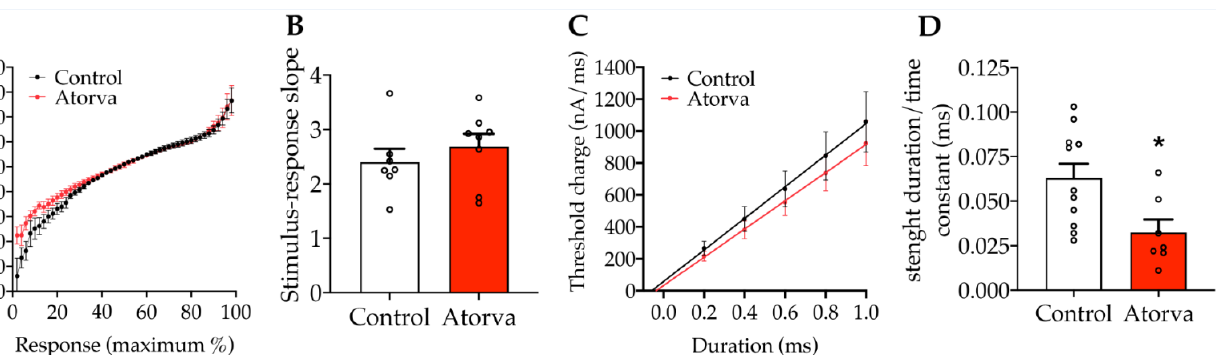
Figure 7. Stimulus-response protocol recordings of C-CAP. Stimulus intensity applied, and C-CAP response measured is presented as the relationship between the fold supramaximal CAP response evoked by crescent current stimuli, normalized on the maximal stimulus applied (expressed in %). Plotted representation of stimulus-response curves ( A ). Stimulus-response curve EC 50 variation has been statistically analysed. Control ( n = 3); Atorva ( n = 3); unpaired t -test, ** p = 0.0031; t = 6.4; df = 4 ( B ). Control = high-fat high-cholesterol diet; Atorva = high-fat high-cholesterol diet plus atorvastatin.